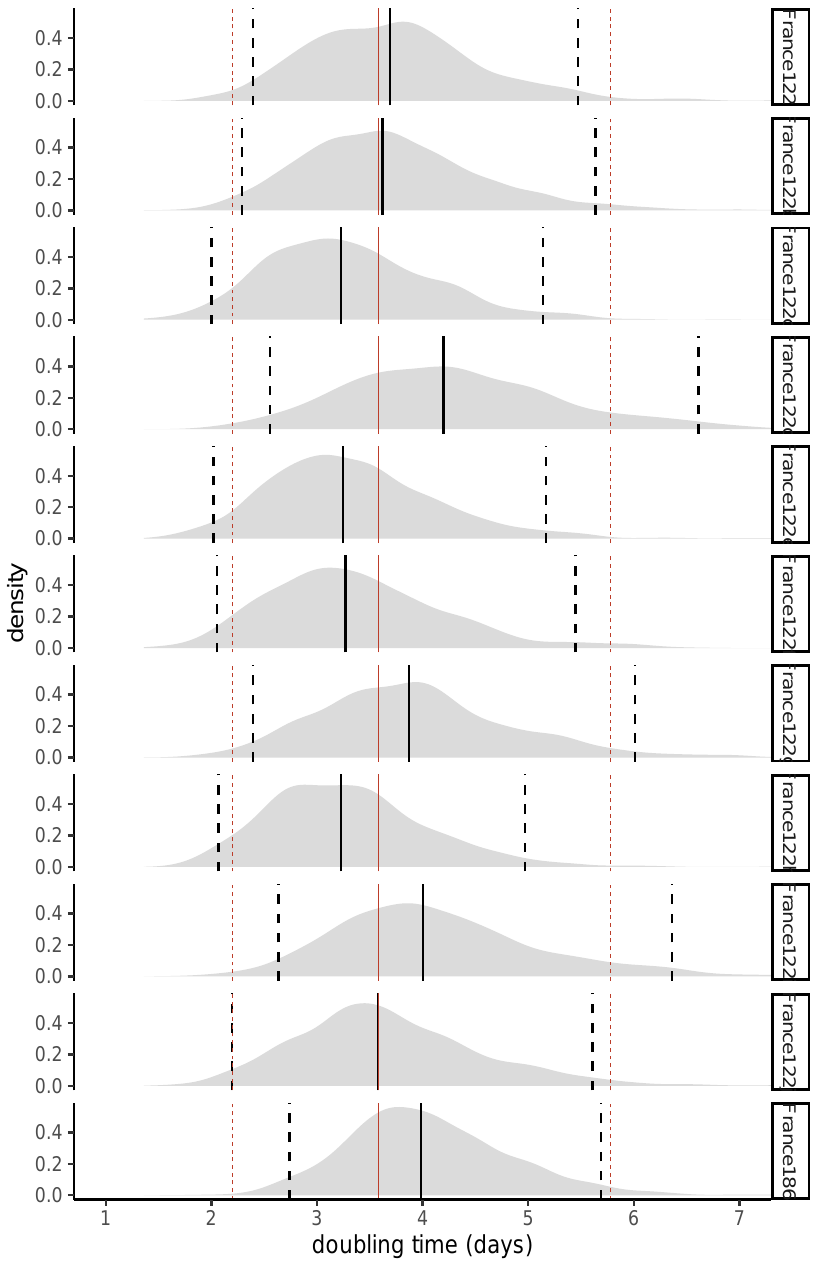
Figure S7 – Doubling time for the 10 trees with 122 leaves sampled. The red lines show the quantiles (0.025, 0.5 and 0.975) for the average of the 10 datasets. The black line shows the quantile for each dataset. The last panel shows the largest phylogeny with 186 leaves (which slightly overestimates the doubling